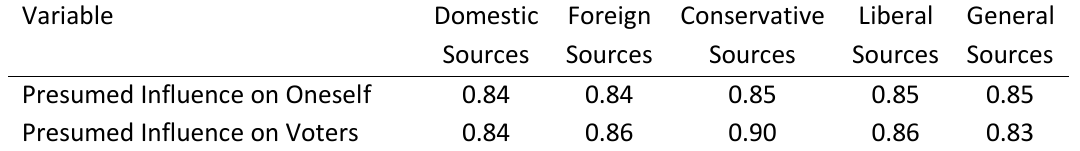
Table A4. Reliability of presumed influence of misinformation on oneself/other